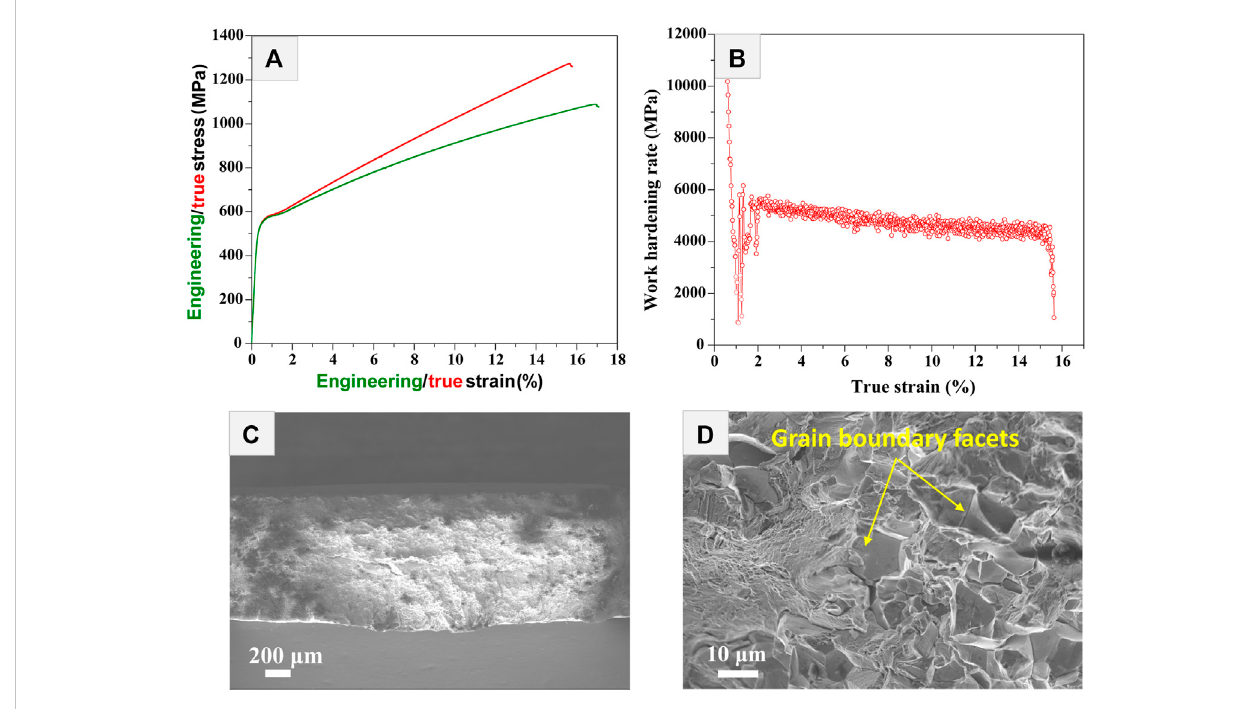
FIGURE 2 (A) Engineering/truetensilestress-straincurves, (B) workhardeningrate-strain curve,and (C,D) macroscopicalandmicroscopicalfracture surfaces of the multicomponent Ni 46.5 Co 24 Fe 8 Al 12.5 Ti 9 L1 2 alloy tested in air at room